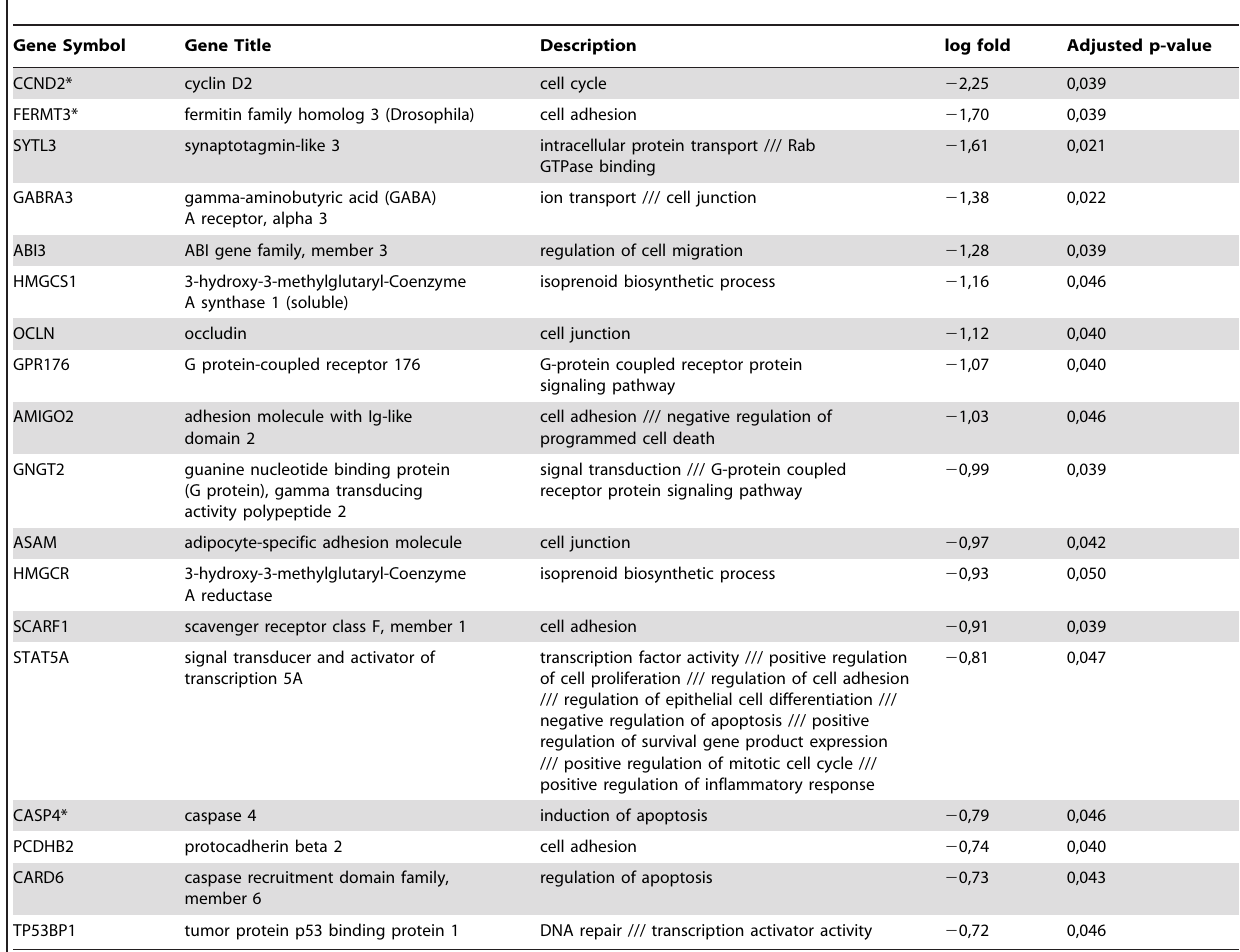
Table 1. List of genes that are down-regulated in INV cells versus REF